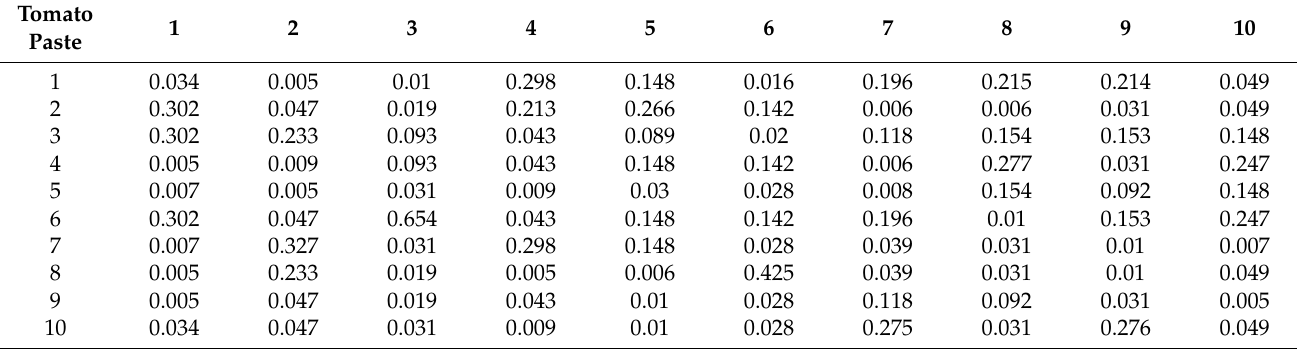
Table A23. Normalization matrix of tomato paste.